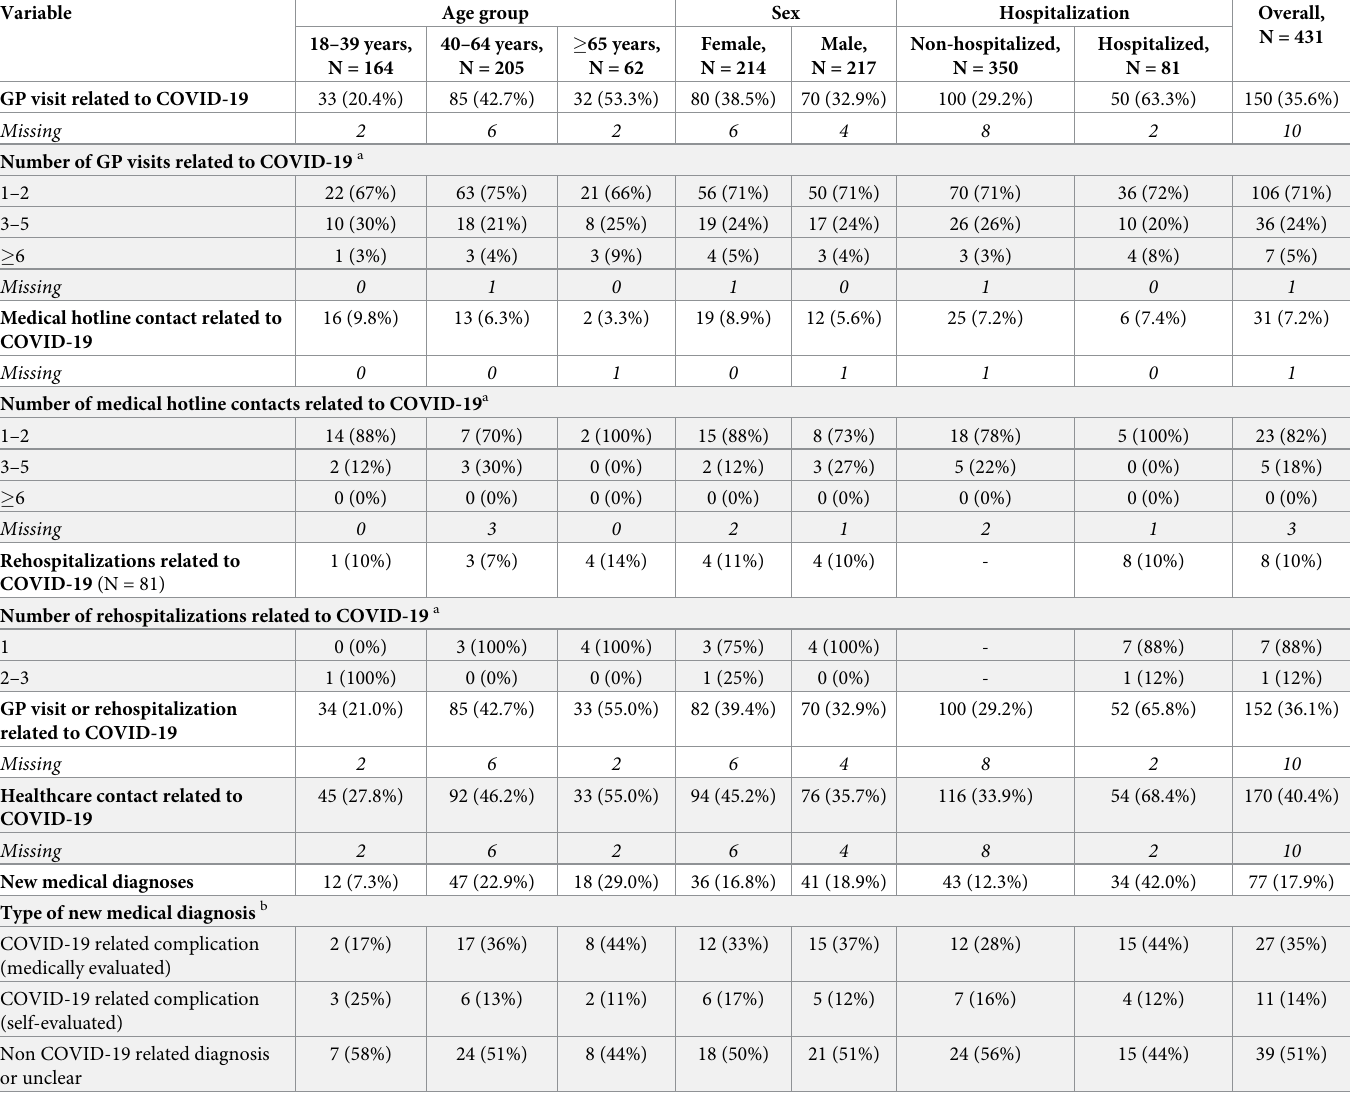
Table 3. Healthcare use and complications at six to eight months after SARS-CoV-2 infection.